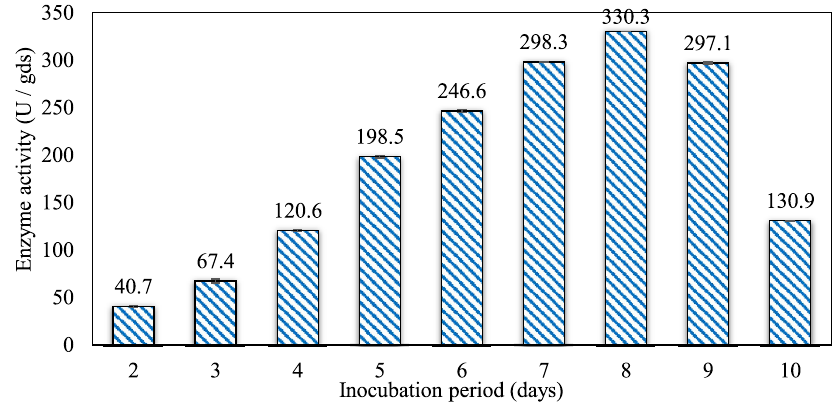
Fig. 4. Effect of different incubation periods on xylanase